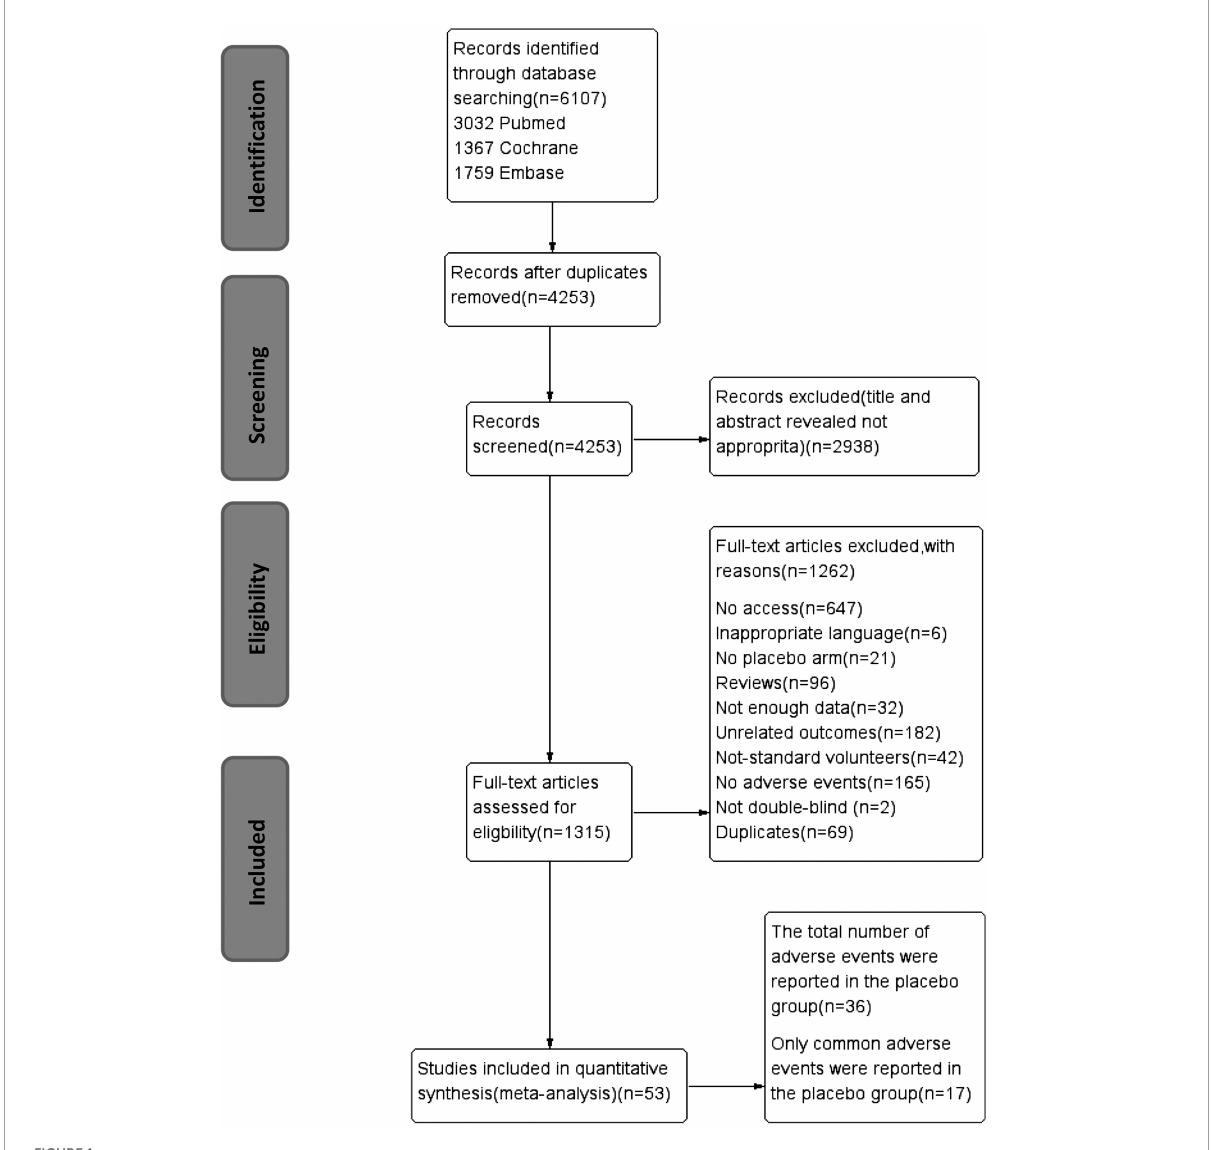
FIGURE1 PRISMA flow diagram of trial inclusion. PRISMA, preferred reporting items for systematic reviews and meta-analyses; RCT, randomized controlled